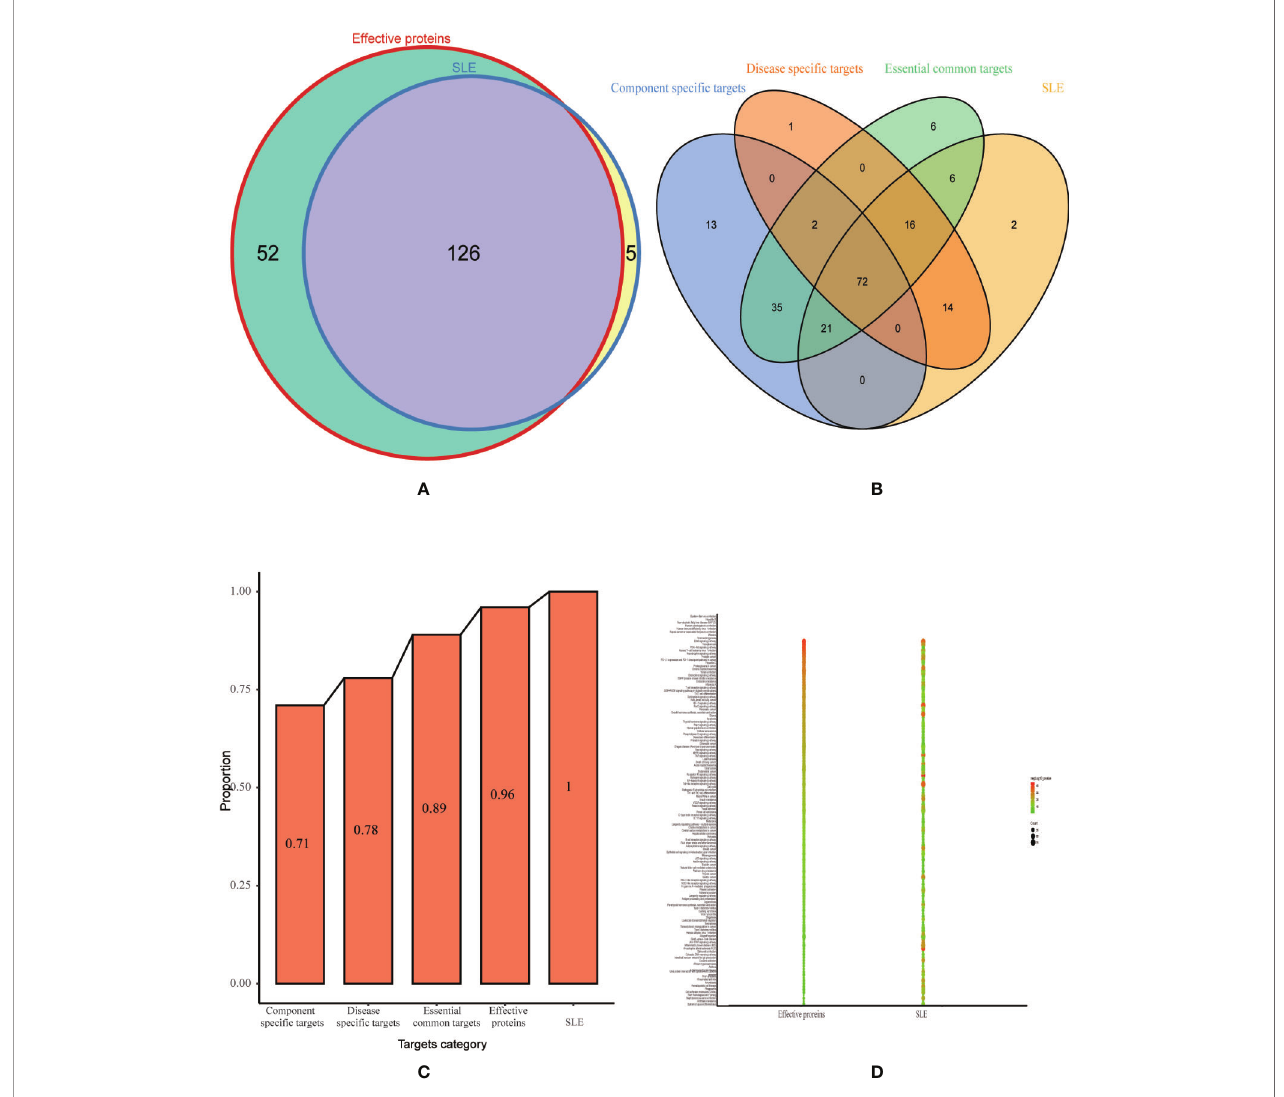
FIGURE 6 | Validation of optimization space. (A) Venn diagram for pathway enrichment analysis of effective proteins and SLE related genes. (B) Venn diagram for pathway enrichment analysis of essential component-speci fi c targets, disease-speci fi c targets, essential common targets and SLE related genes. (C) The proportion histogram of enriched pathways of three categories (component-speci fi c targets, disease-speci fi c targets, essential common targets) and effective proteins compare with the enrichment pathways of pathogenic genes. (D) Bubble diagram for common pathway enrichment analysis of effective proteins and SLE related